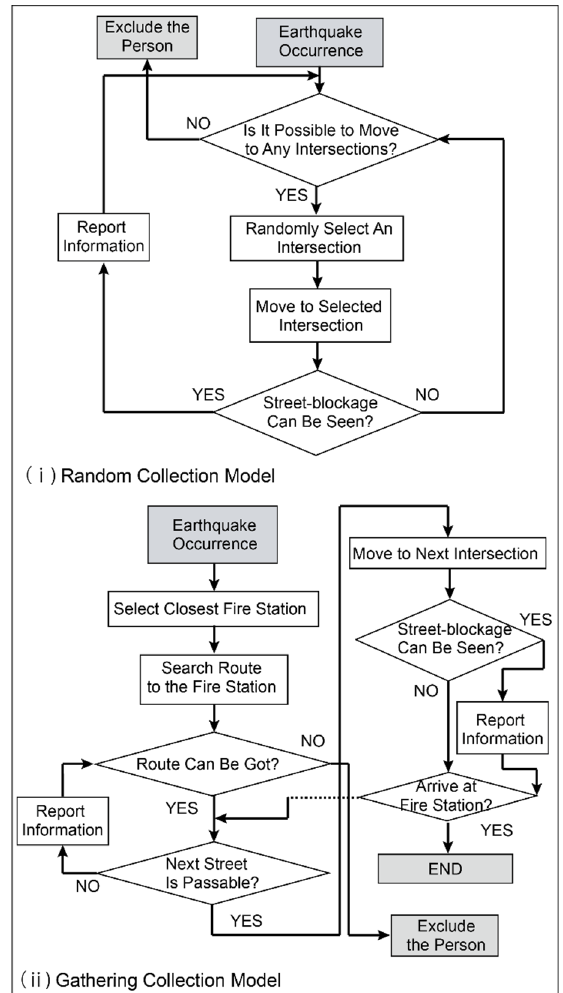
Figure 10. Collecting information model (Agent-based model)